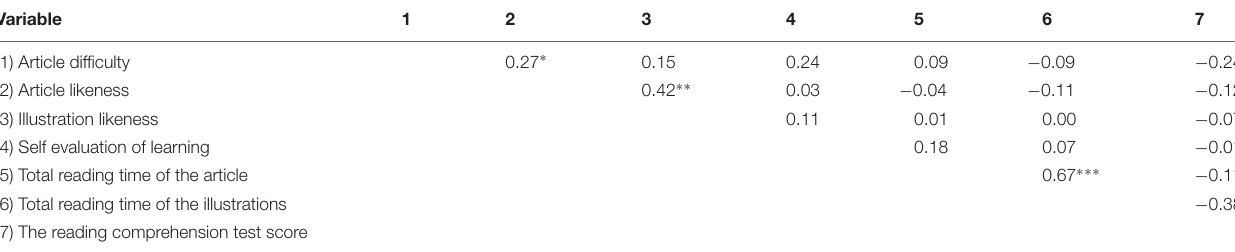
TABLE 6 | Correlations between questionnaire ratings, eye movements, and reading performance.